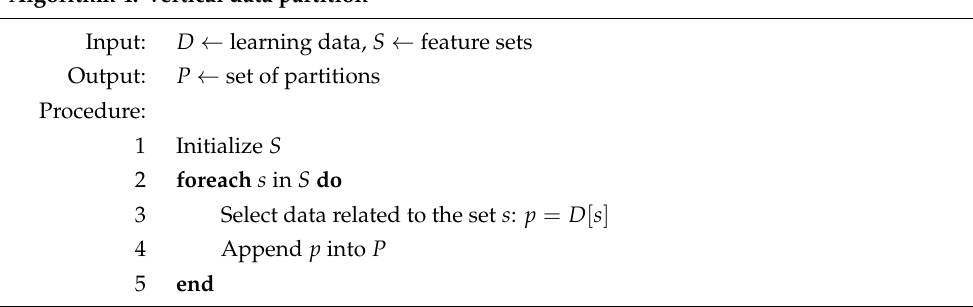
Algorithm 4. Vertical data